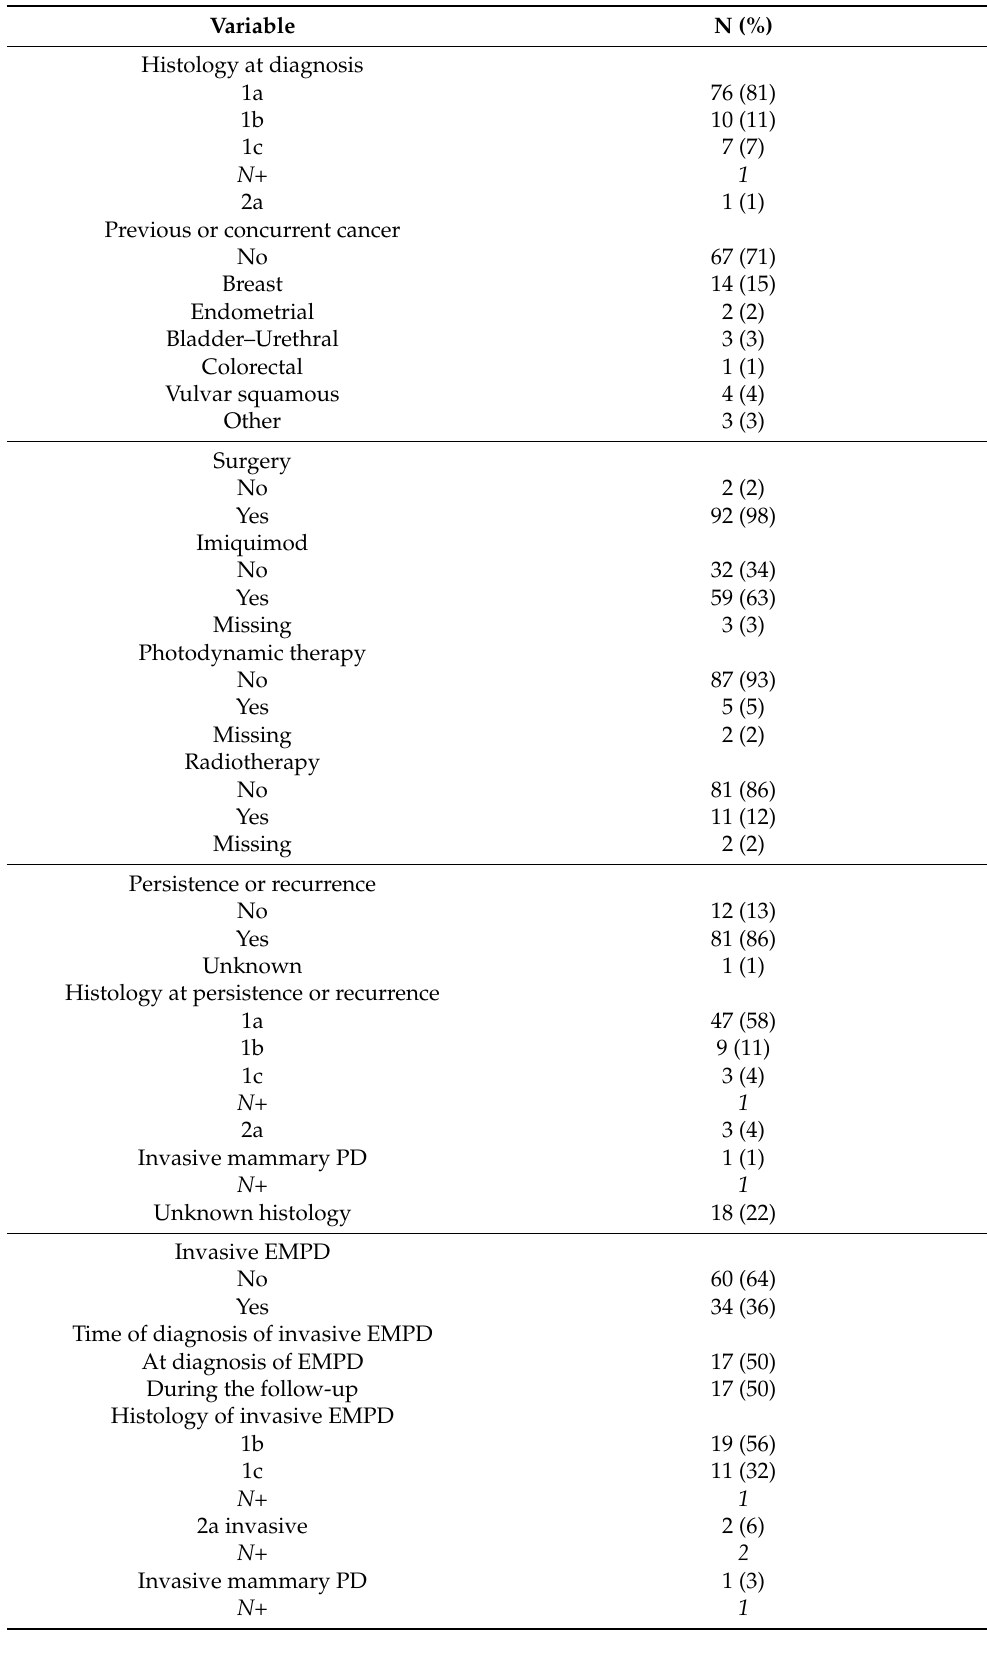
Table 1. Clinical and pathological characteristics of women affected by vulvar EMPD at first diagnosis and during follow-up (N =